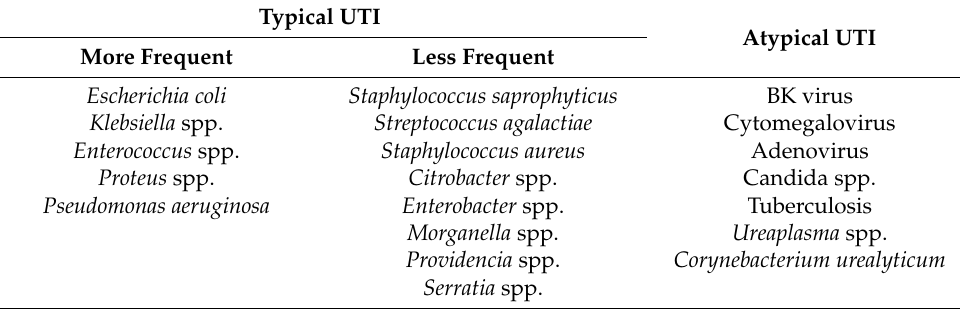
Table 2. Microorganisms causing UTI in KT